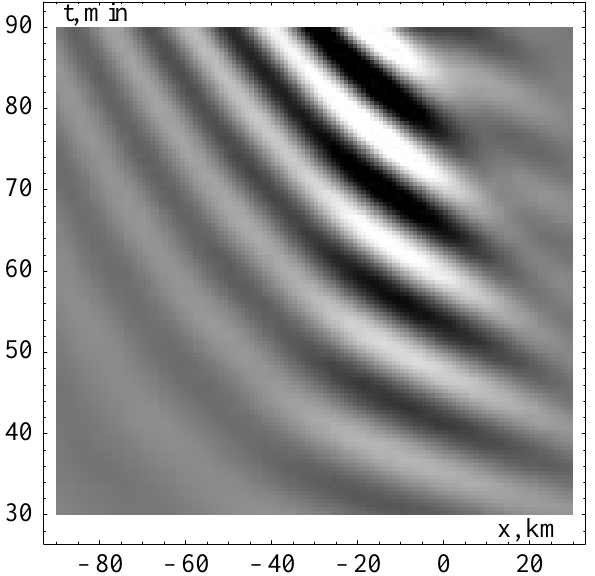
Fig. 13. Temporal and x -dependence of the amplitude of the paral- lel electric current above the ionosphere. The FLR position corre- sponds to x = 0, poleward is to the